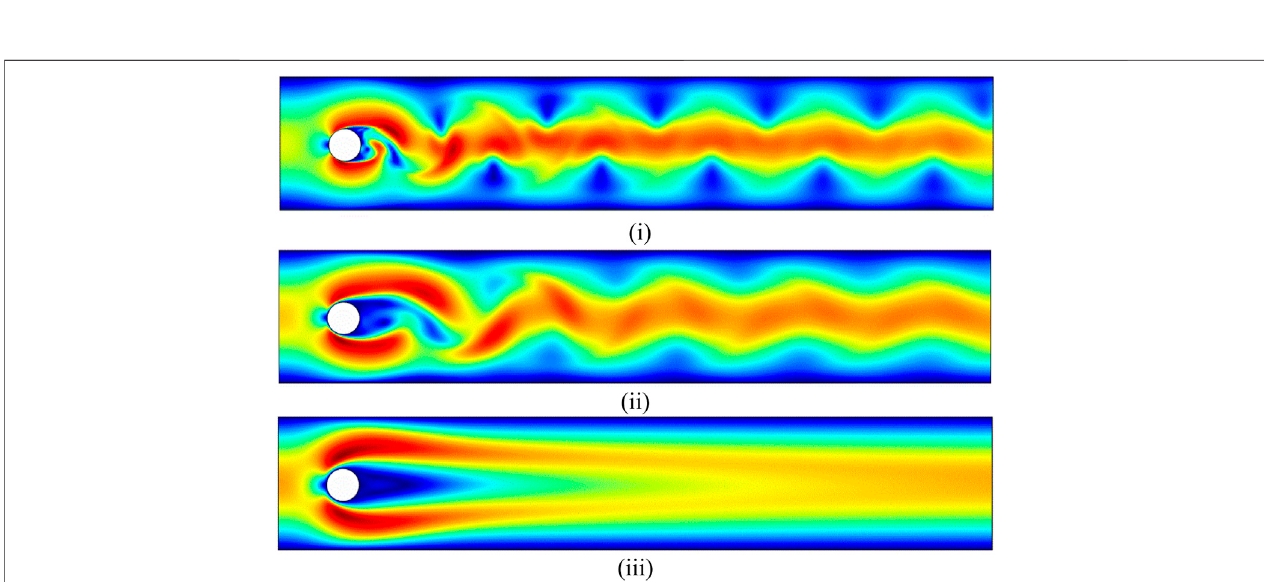
FIGURE 4 | In fl uence on velocity for ( i ) n (cid:2) 0 . 6 , ( ii ) n (cid:2) 1 , ( iii ) n (cid:2) 1 . 4 with Pr (cid:2) 7 and Re (cid:2) 100 at t (cid:2) 5 . (cid:129) At the surface of heaters (plates): u (cid:2) 0 , v (cid:2) 0 , θ (cid:2) 1 (cid:129)